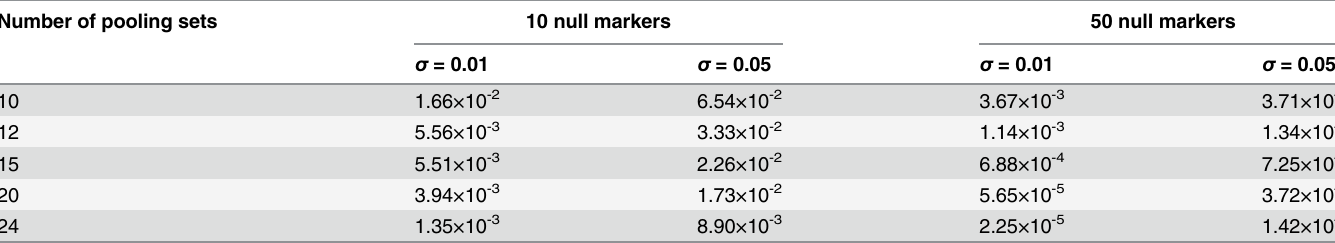
Table 1. The results of a permutation test for oligoset DNA pooling studies for the example data. Number of pooling